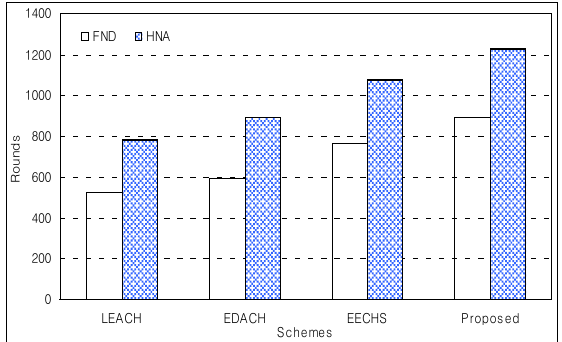
Fig. 4. The comparison of the schemes in terms of FND and HNA.